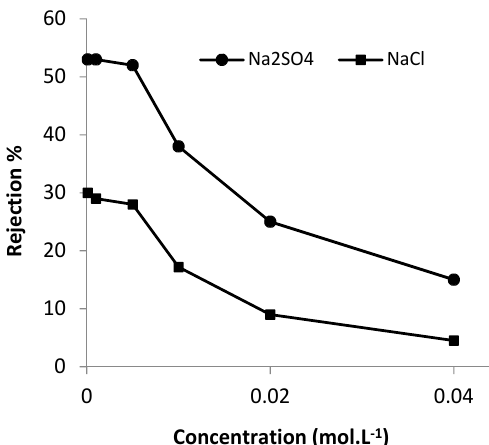
Fig. 6: Effect of operating pressure on pure water flux. Fig. 7: Effect of feed concentration on the rejection